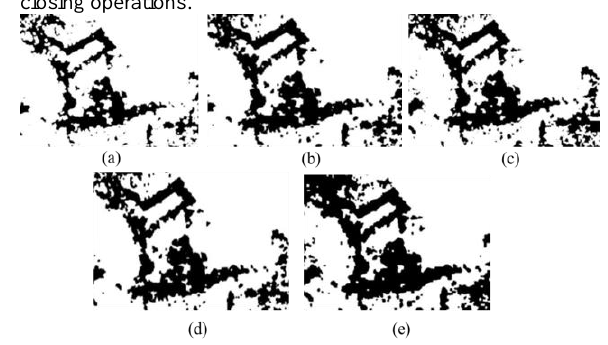
Figure12. Formula (3) processing